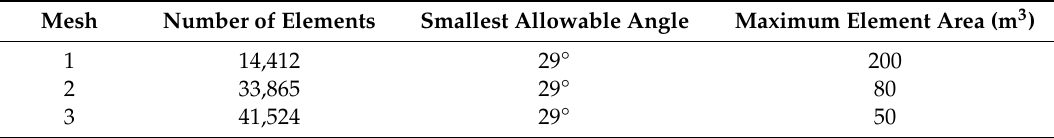
Table 1. Setup for the three sets of